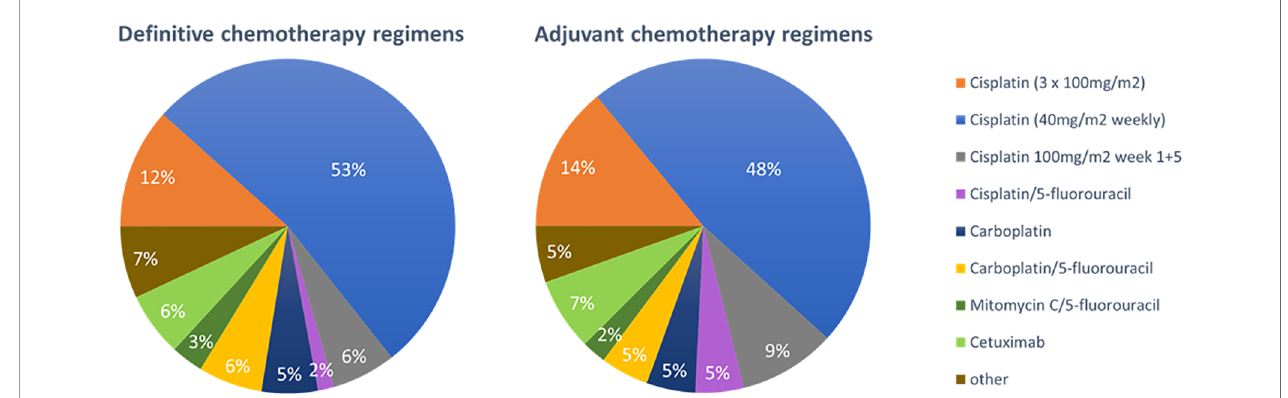
FIGURE 5 | Pie charts for the preferred concomitant chemotherapy regimens in the chemoradiation of elderly HNSCC patients in the de fi nitive (n=129) and adjuvant (n=128) setting.